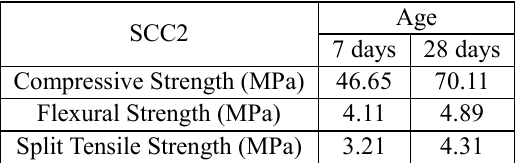
Hardened properties for SCC2